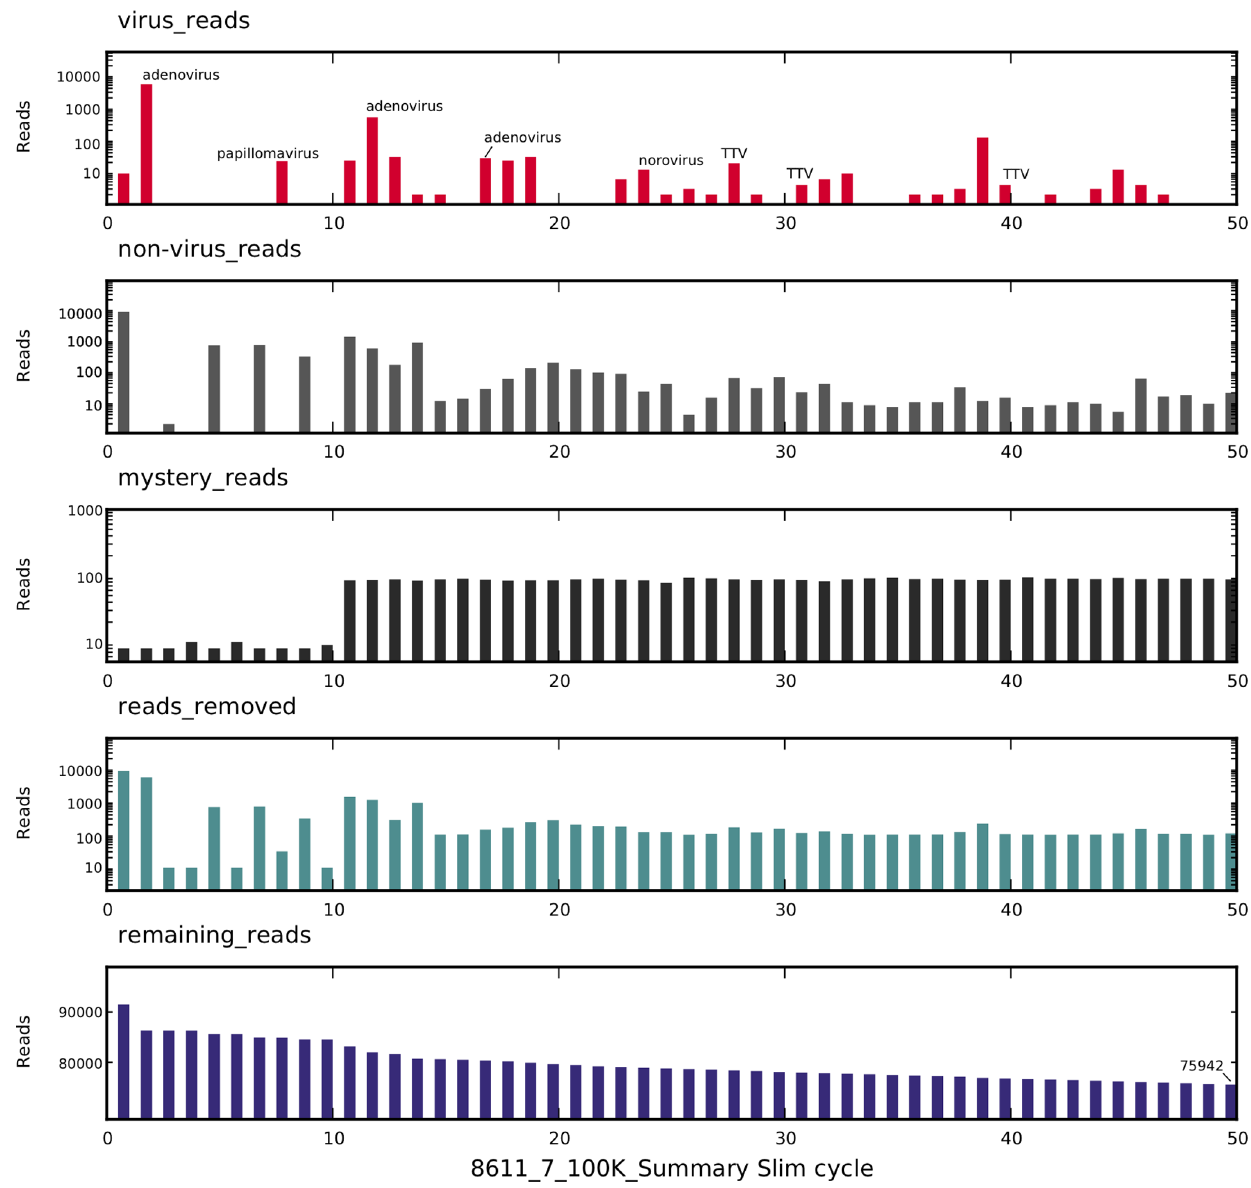
Figure 5. A demonstration of SLIM function. 100,000 random reads reads from sample 17 were processed with SLIM. For each cycle, the number of reads classified as virus, non-virus and mystery, the number of reads removed and the number of reads remaining are plotted. The cycle number and elapsed time is indicated below the graph, the cycle of identification of specific viruses is marked in the upper (virus_reads) graph.